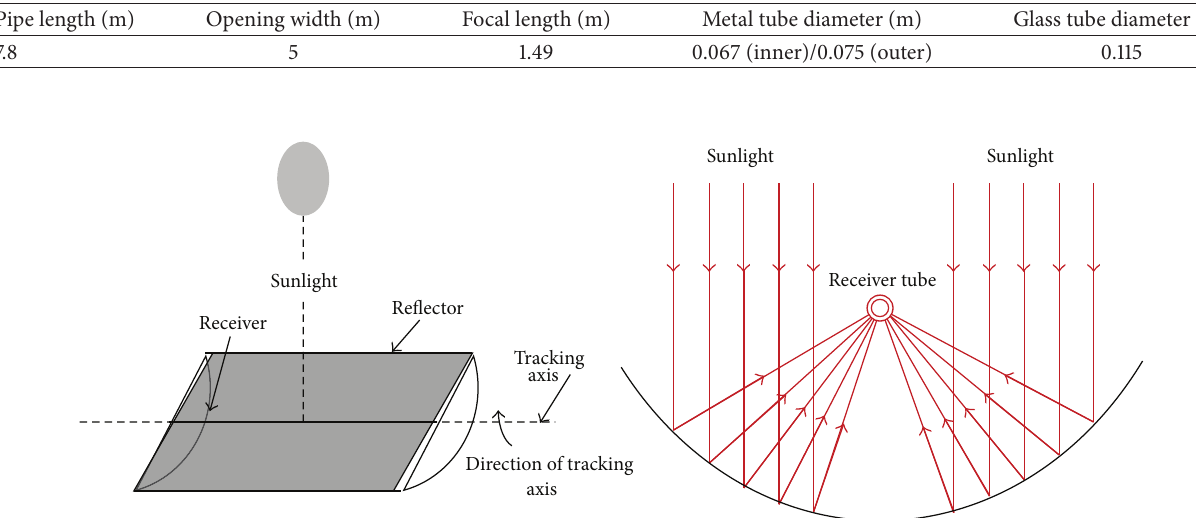
Table 1: The basic parameters of the LS-2 collector.